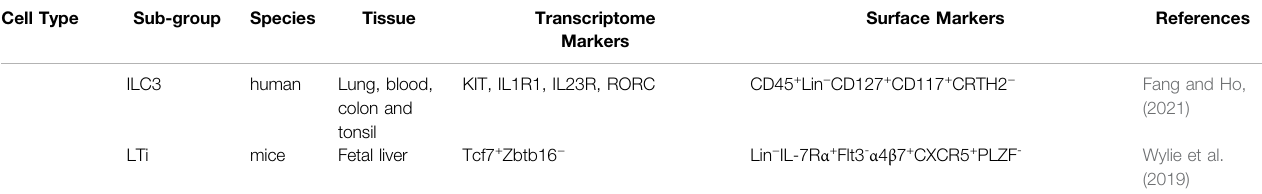
TABLE 2 | ( Continued ) Phenotypic markers of innate immune cells using CITE-seq or scRNA-seq. pDC, plasmacytoid DC. cDC1, type1 conventional DC. cDC2, type2 conventional DC. mregDC, mature DC expressing regulatory molecules. moM Φ , monocyte-derived macrophage. AM Φ , alveolar macrophage (tissue-resident macrophage). NSCLC, non-small cell lung cancer. PBMC, peripheral blood mononuclear cells. OVC, ovarian cancer. BAM, border-associated macrophages. CRC, colorectal cancer. Transcriptomemarkersaremainly derivedfrom clusteringresults, while surfacemarkersarecollectedbasedon antibody-derivedtags(ADT) byCITE-seq or